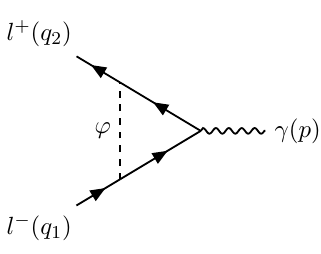
Figure 4 . One-loop contribution from a real scalar ϕ to the anomalous magnetic moment of a fermion l